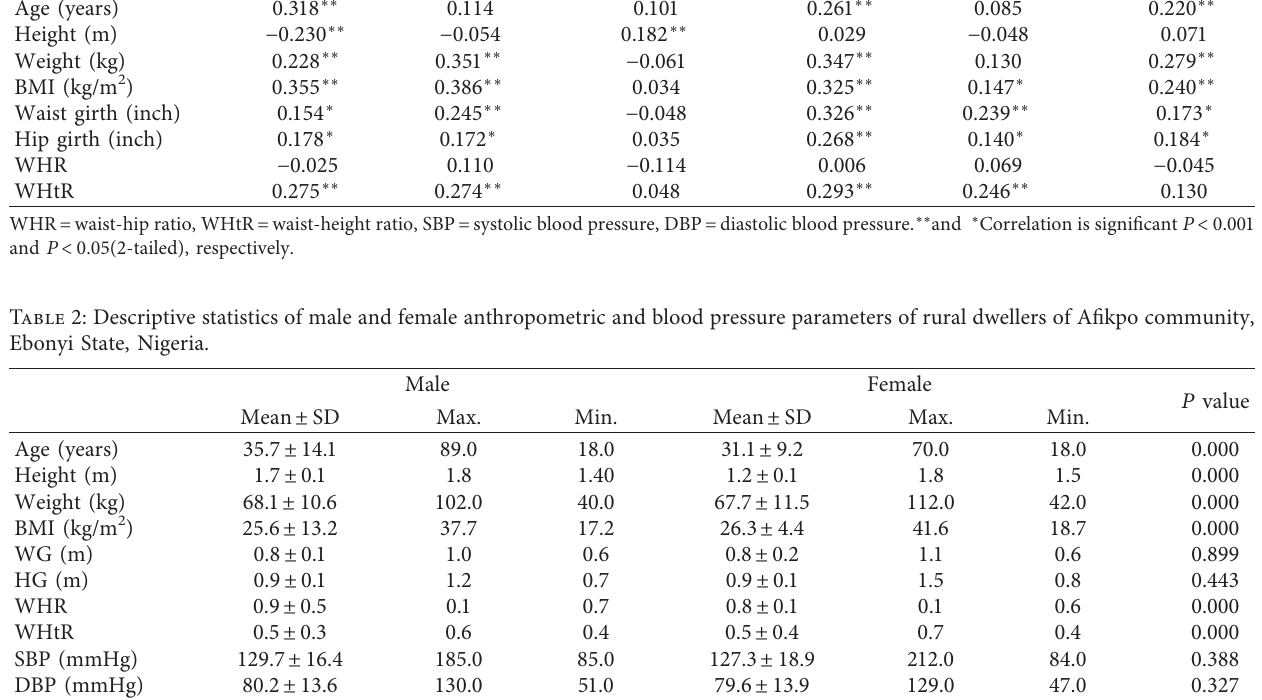
Table 3: Prevalence of hypertension among rural dwellers of Afikpo community, Ebonyi State, Nigeria. Sex Hypertension (%) Normal (%) χ 2 P value Male 26 74 0.567 0.452 Female 22 78 Age range (18–89 years); blood pressure cutoff points